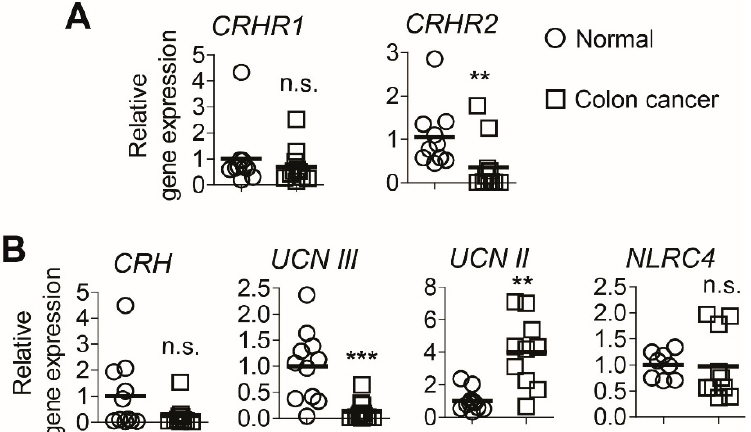
Figure 1. The mRNA levels of corticotropin-releasing hormone receptor 2 ( CRHR2) and its cognate ligand urocortin ( UCN) III are reduced in human colon cancer tissues relative to normal tissues. ( A , B ) Relative mRNA expression levels of CRHR1 and CRHR2 ( A ) and the CRH family member and NLRC4 ( B ) were evaluated by quantitative real-time PCR (qPCR) with colon cancer tissues obtained from colon cancer patients (n = 11) and unmatched normal tissues (n = 10) independently obtained from healthy control subjects. ** p < 0.01, *** p < 0.001, n.s. stands for not significant (Mann–Whitney U test). Horizontal bar in each graph indicates mean.